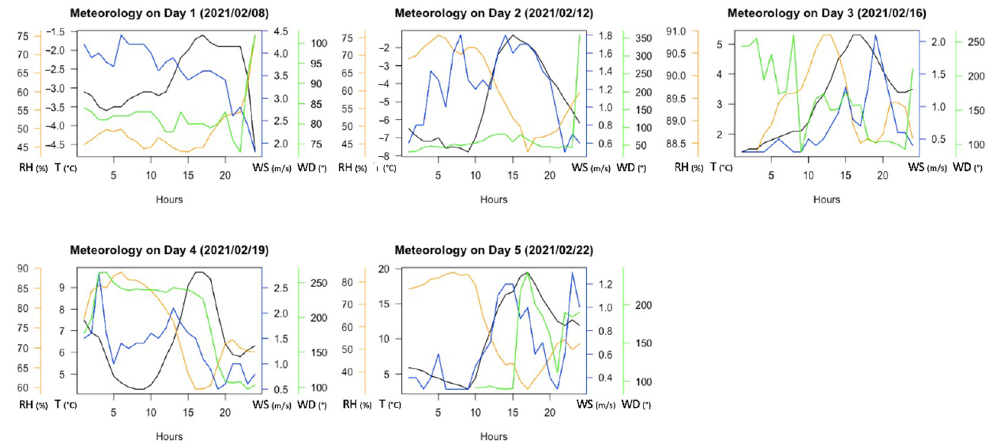
Figure A1. Variation of meteorological conditions on the selected days of this study. Plots for each day show hourly data of wind speed (blue lines), wind direction (green lines), temperature (black lines), and relative humidity (orange lines). Meteorological data from the ground weather station Finkenwerder West.